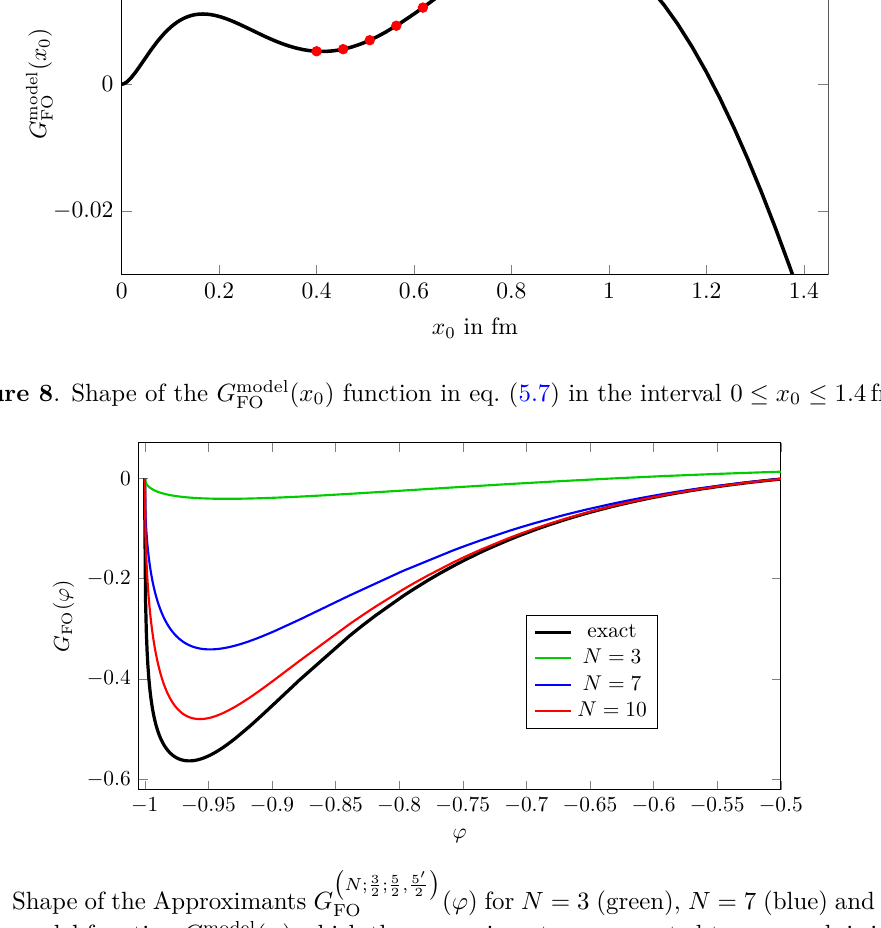
Figure 9 . Shape of the Approximants G (red). The model function G model